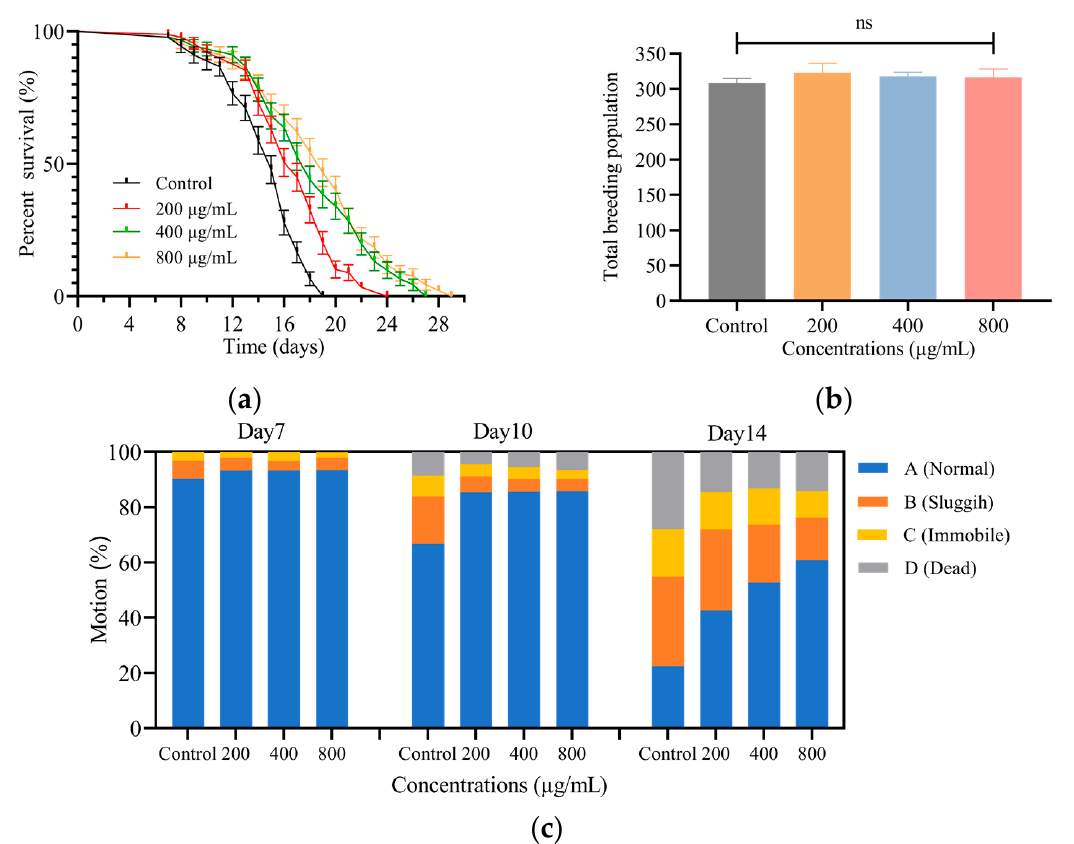
Figure 1. ( a ) SH prolonged the lifespans of C. elegans . The black curve represent as the control group and the colored curves represent the SH administration groups. The GraphPad Prism 9.0 survival curve function was used to analyze the growth of nematodes. ( b ) The reproductive capacity of C. elegans was not found to be impaired by SH. There was no significant difference in the number of nematode offspring treated with SH compared with the control group. ( c ) SH slowed down the decline in motility of C. elegans . The number of sluggish and immobile nematodes gradually increased in the control group, but the decline of normal nematodes was slowed down by SH treatment. Three independent experiments were carried out. Notes: ns meant not